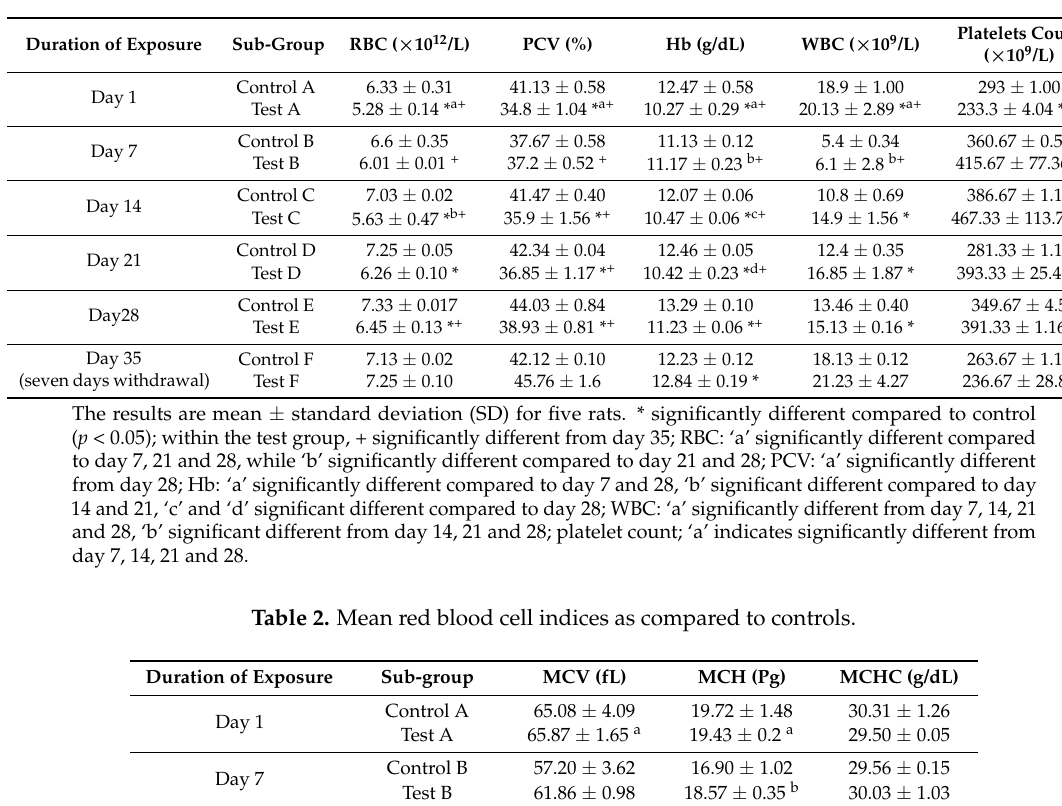
Table 1. Mean haematological indices as compared to controls.